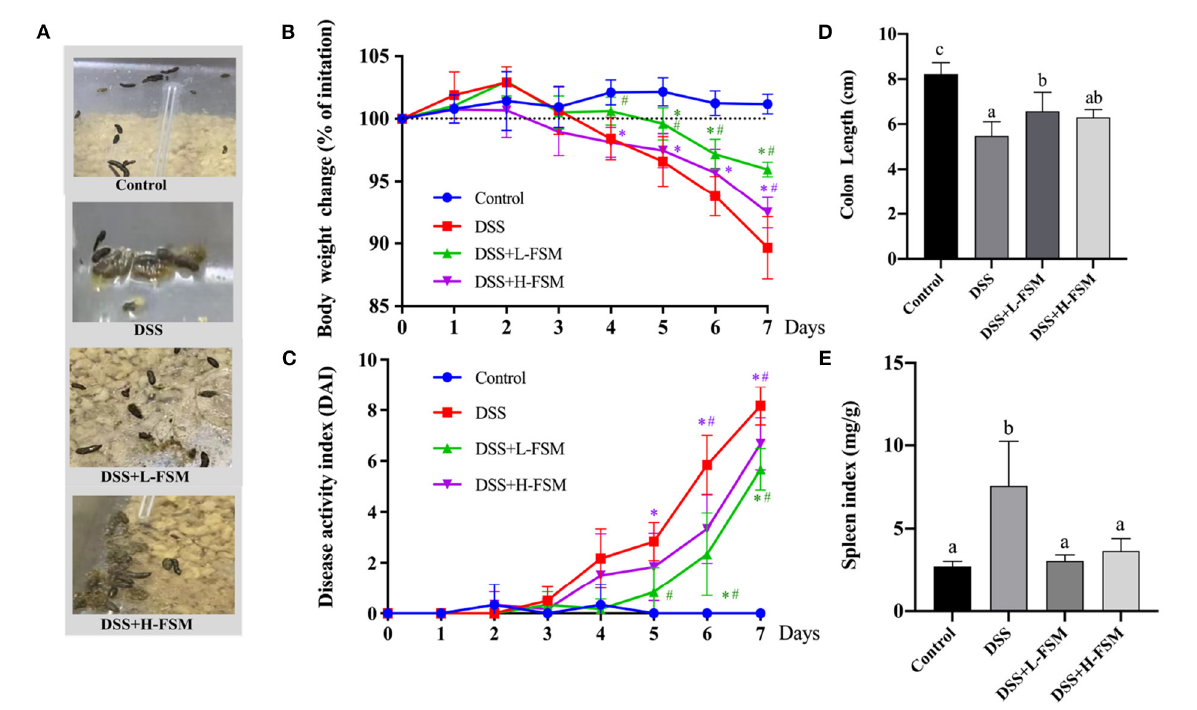
FIGURE6 Effect of fermented soymilk on the health condition of DSS-induced colitis mice. (A) Fecal condition; (B) Daily body weight changes throughout the entire duration of the DSS treatment ( n = 6 per group); (C) Disease activity index throughout the entire duration of the DSS treatment ( n = 6 per group); (D) the lengths of colon ( n = 6 per group); (E) Spleen-to-body weight ratio ( n = 6 per group). Control, control group; DSS, colitis model group; DSS + L-FSM, low-dose fermented soymilk (0.8 g/kg BW) group; and DSS + H-FSM, high-dose fermented soymilk (1.6 g/kg BW) group. (a–d) Different letters indicate significant differences between groups according to Tukey’s HSD test, * p < 0.05 relative to Control group, # p < 0.05 relative to DSS